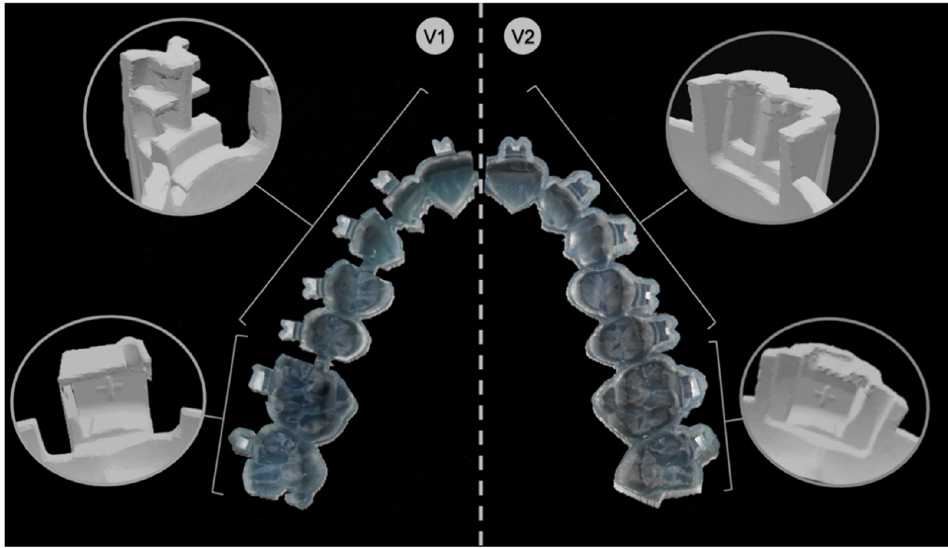
Figure 3. Direct comparison between the design of version 1 ( V1 ) and version 2 (V2 ).